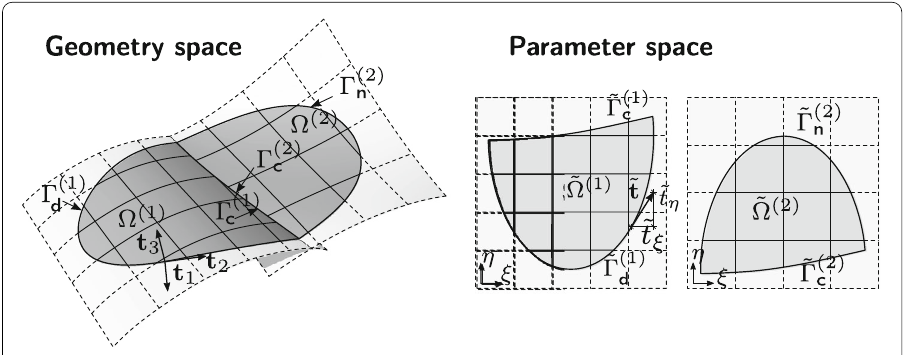
Fig. 5 Different types of B-Rep edges, e.g. for coupling of two patches (cid:6) c or imposition of Dirichlet (cid:6) d and Neumann (cid:6) n boundary